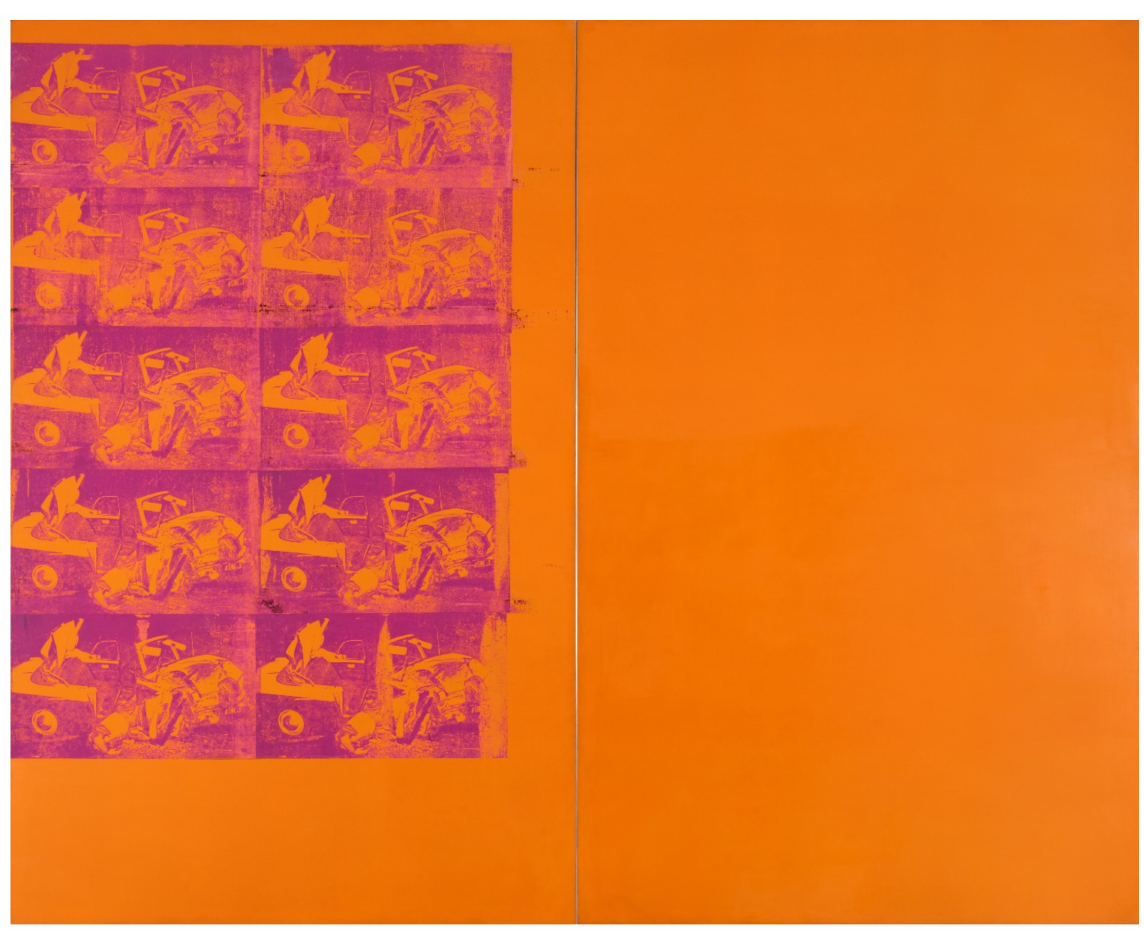
Figure 1. “ Orange Car Crash ” by Andy Warhol based on a silkscreen canvas (left) paired with a monochrome canvas (right). Photo © mumok—Museum Moderner Kunst Stiftung Ludwig Wien, on loan from the Ludwig collection,